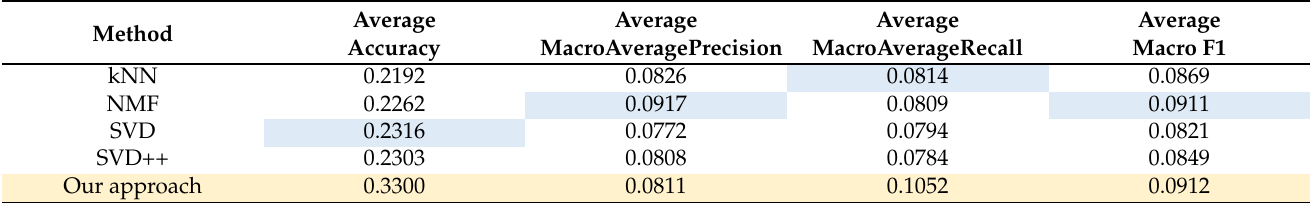
Table 9. Comparison of our proposed approach with other approaches in Experiment 2.